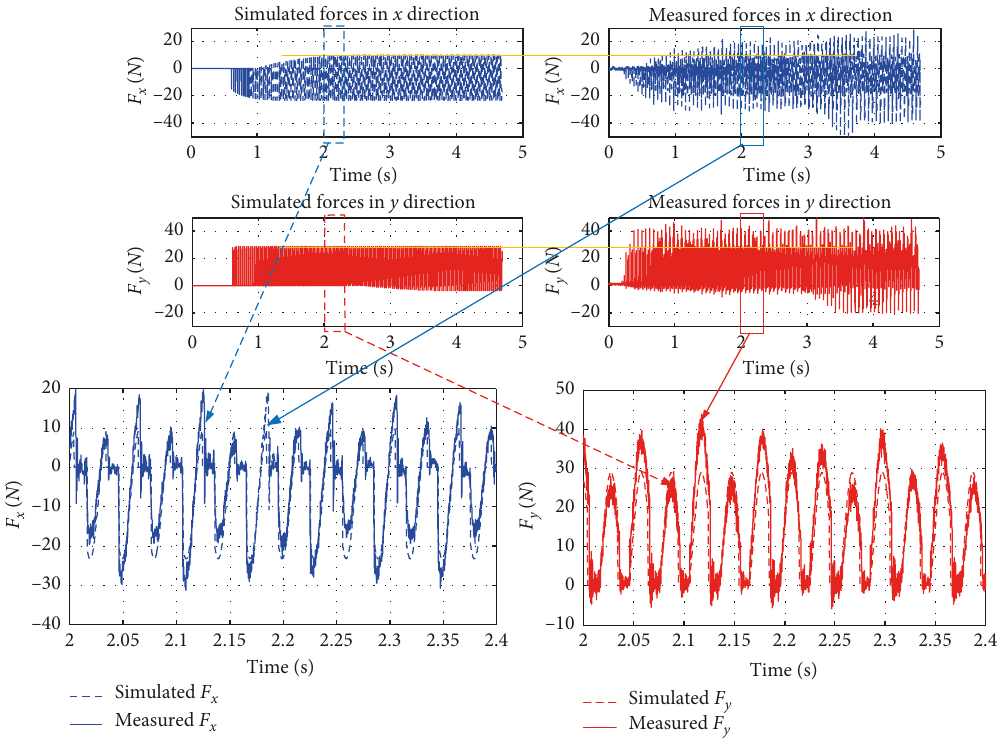
Figure 16: Detailed comparison of the simulation results and the experimental results.